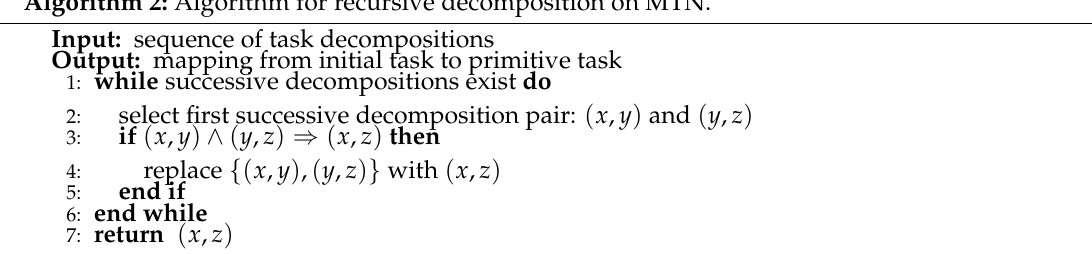
Algorithm 2: Algorithm for recursive decomposition on